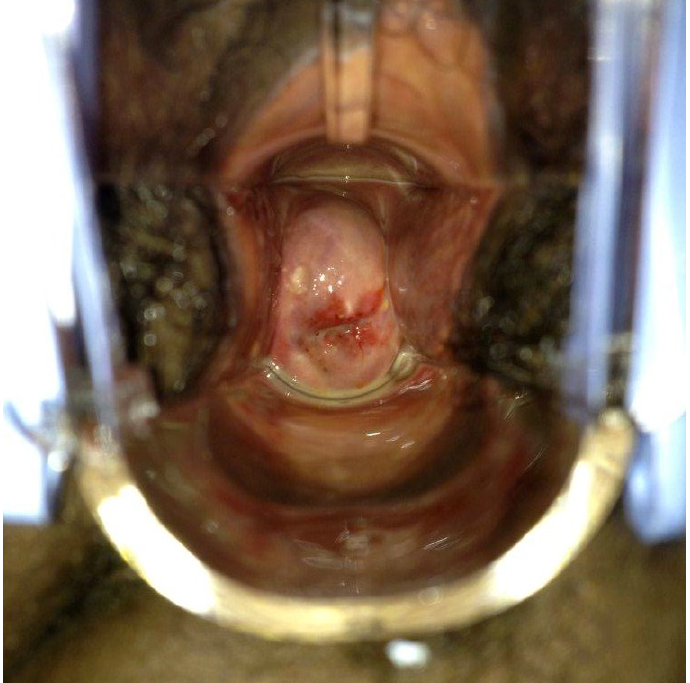
Figure 2. Speculum exam revealed erythematous, swollen cervix with white discharge and notable vascular changes surrounding the os.